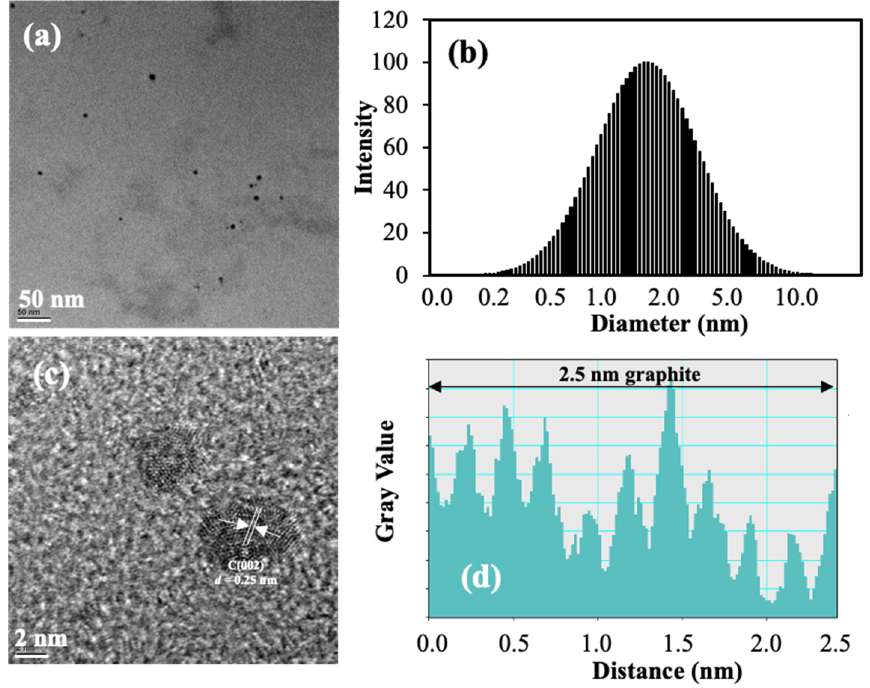
Figure 1. ( a ) TEM images of Arg CDs and ( b ) their particle size distribution by DLS measurements; ( c ) HR-TEM images of Arg CDs and ( d ) the corresponding gray value plot.